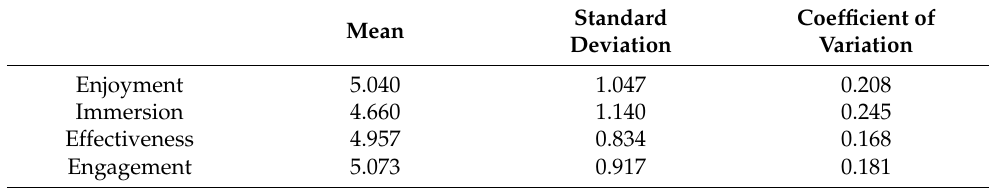
Table 1. Mean values, standard deviations and coefficients of variation of scores from the questionnaire.